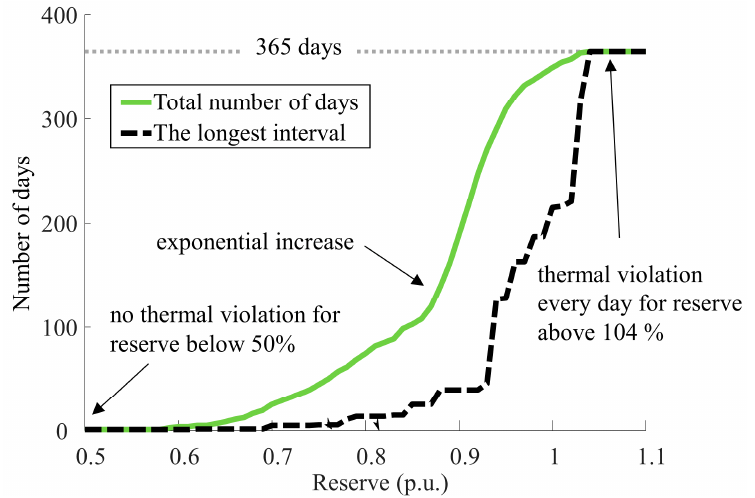
Figure 4. Number of days where thermal limits are reached.